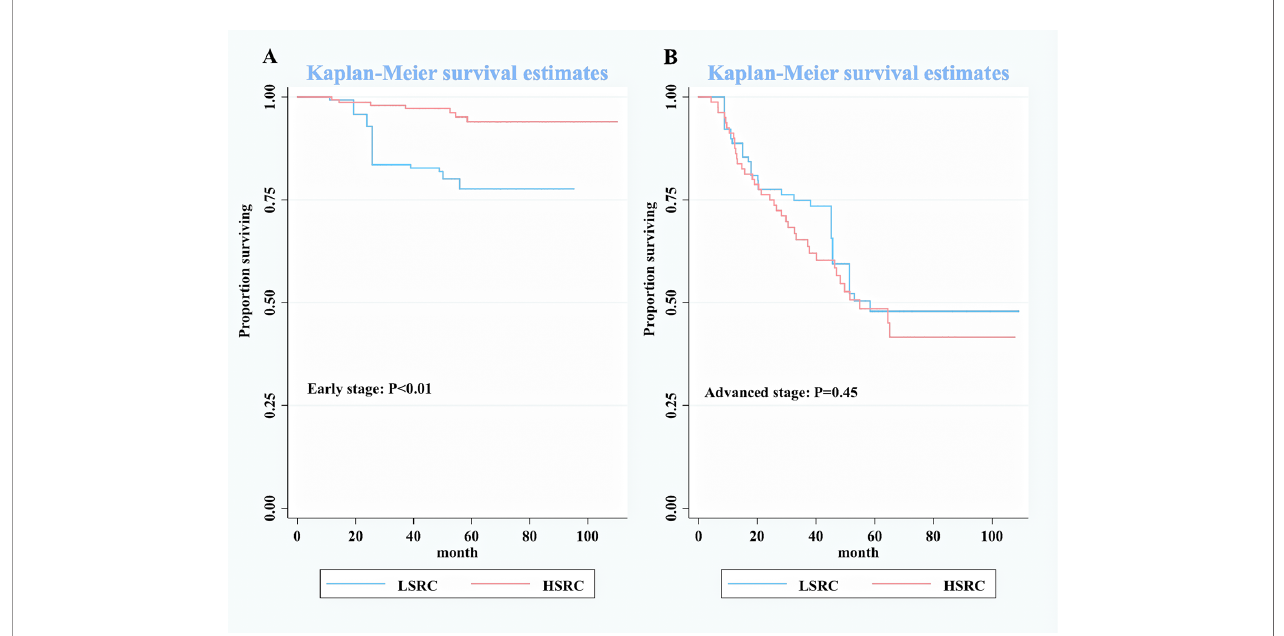
FIGURE 2 | Kaplan – Meier survival curves for patients by stage between low-proportion signet ring cells and high-proportion signet ring cells. (A) Early stage. (B) Advanced stage.